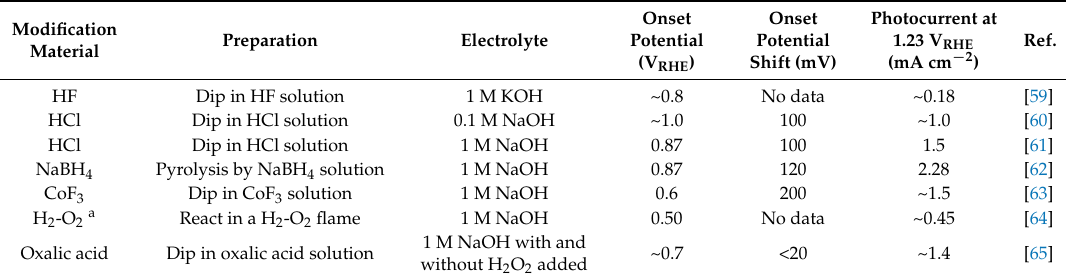
Table 4. List of surface chemical etching for surface modification on hematite nanostructures. Note: a directly oxidizing Fe foil in a H 2 -O 2 flame at around 1700